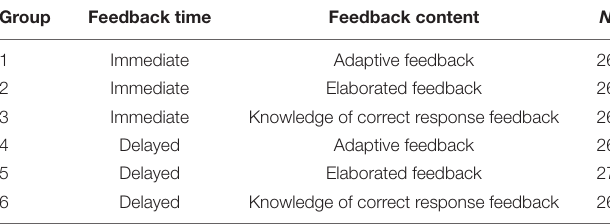
TABLE 1 | Summary of design of experimental